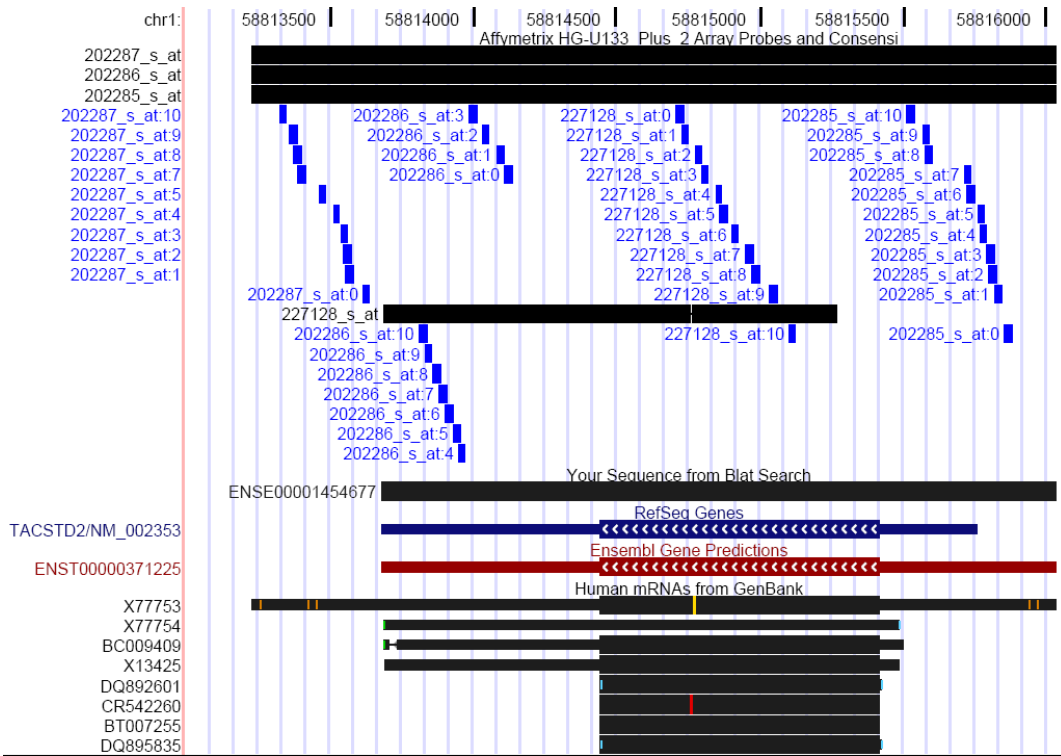
Figure S3. UCSC screen shot for